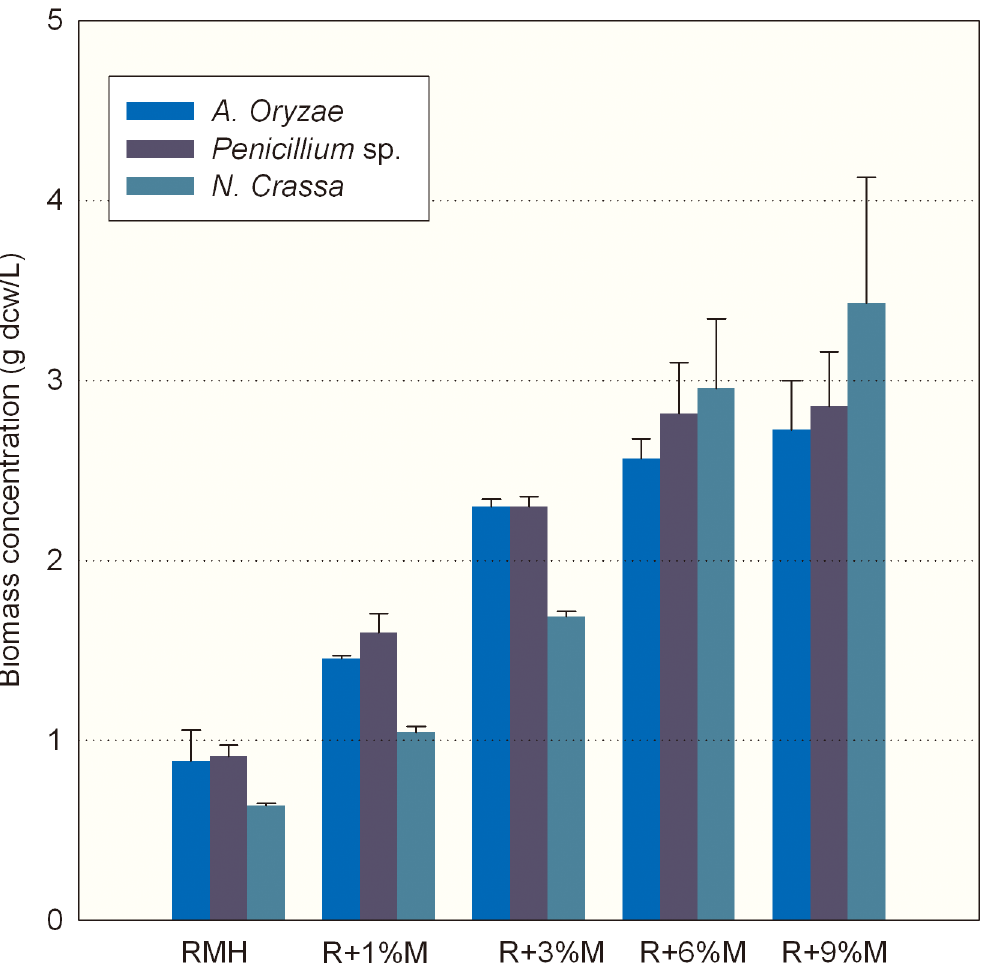
Fig 6. Biomass concentration of C . cohnii grown on individual RMH supplemented with waste molasses. The meal hydrolysates produced by individual fungal stains were supplemented with different levels of molasses. Data of biomass concentration are means of three replicates, and error bars show standard